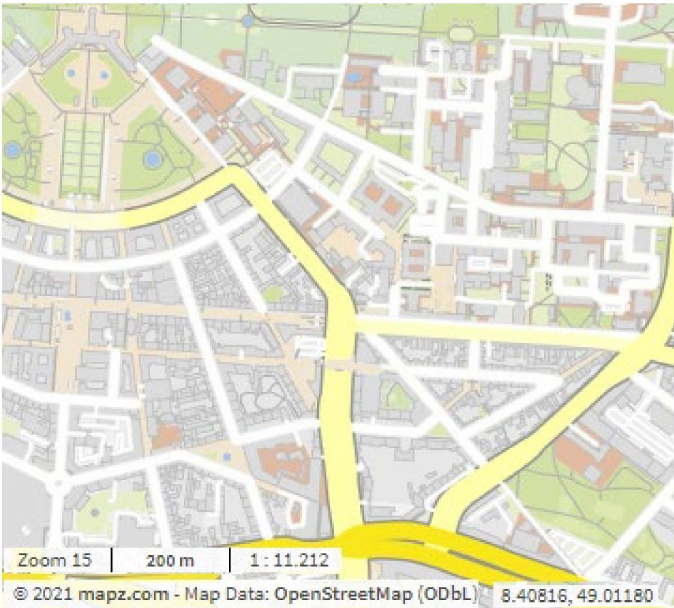
Figure 2. Area where thermal drone images were collected. Map of the city of Karlsruhe, district Innenstadt-Ost